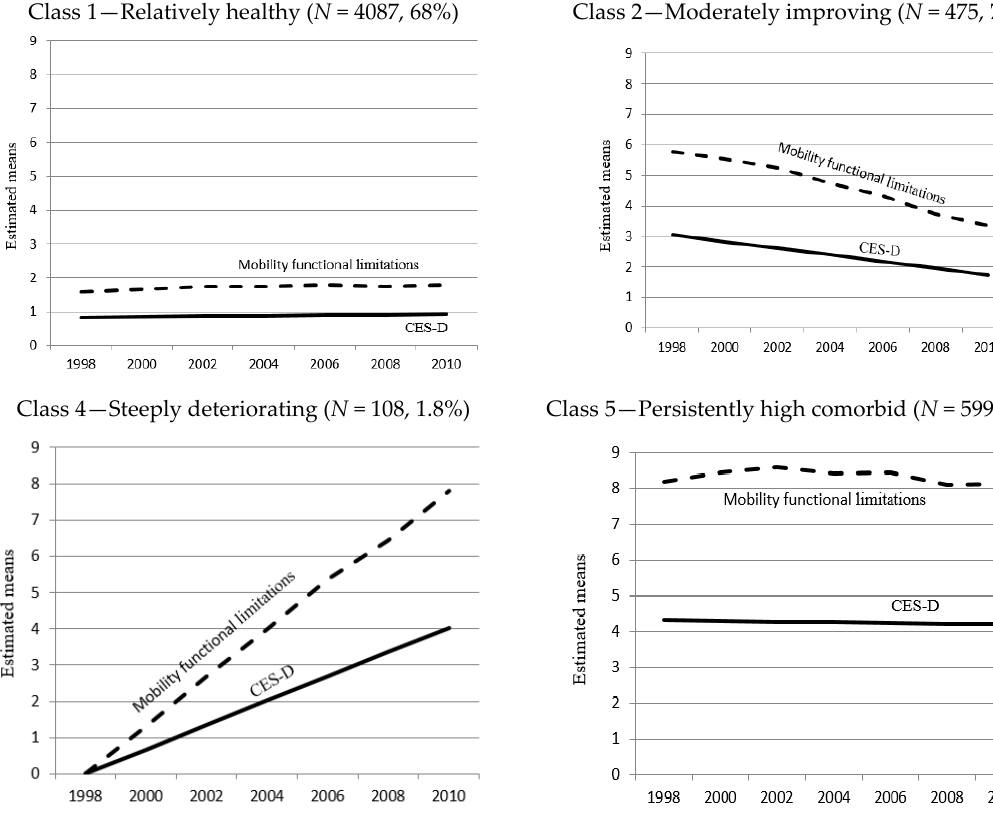
Figure 2. Joint trajectories of mobility functional limitation and Center for Epidemiologic Studies Depression Scale (CES-D).